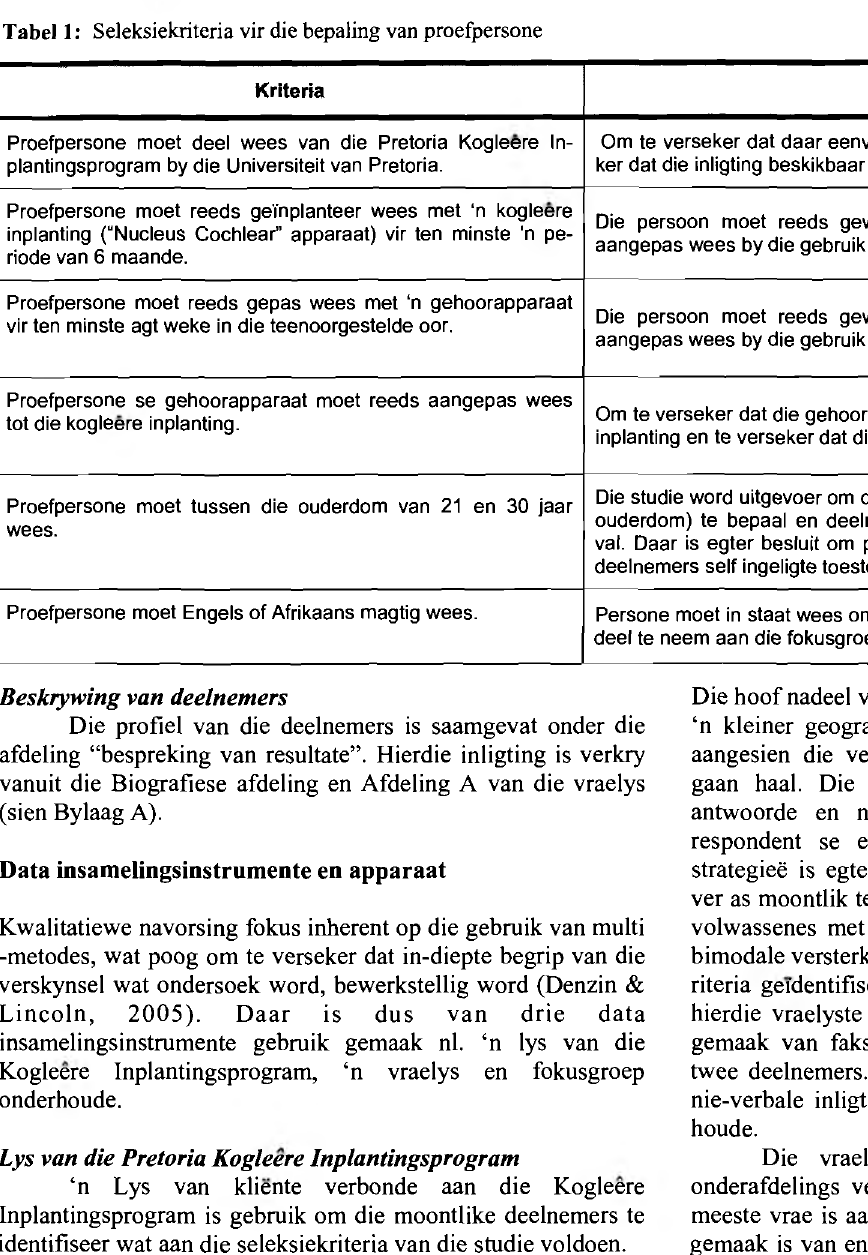
Tabel 1: Seleksiekriteria vir die bepaling van proefpersone Kriteria